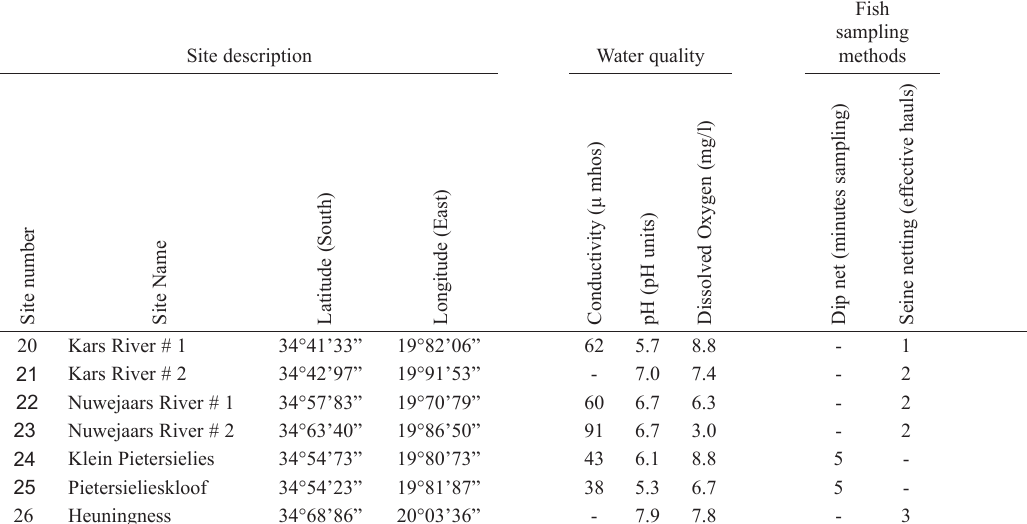
Table 2 Fish species caught at seven sites on the Heuningness catchment during the October 2005 river­health assessment. Included are average scores for three water quality parameters taken during the seasonal assessment. Site numbers as per Fig.